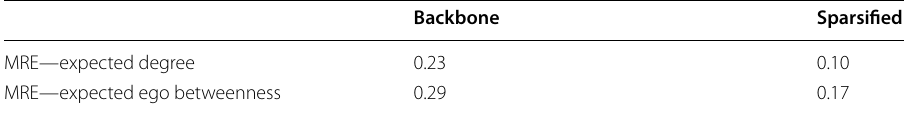
Table 1 Mean relative error of expected degree and expected ego betweenness in the backbone and the sparsified graph in Fig.